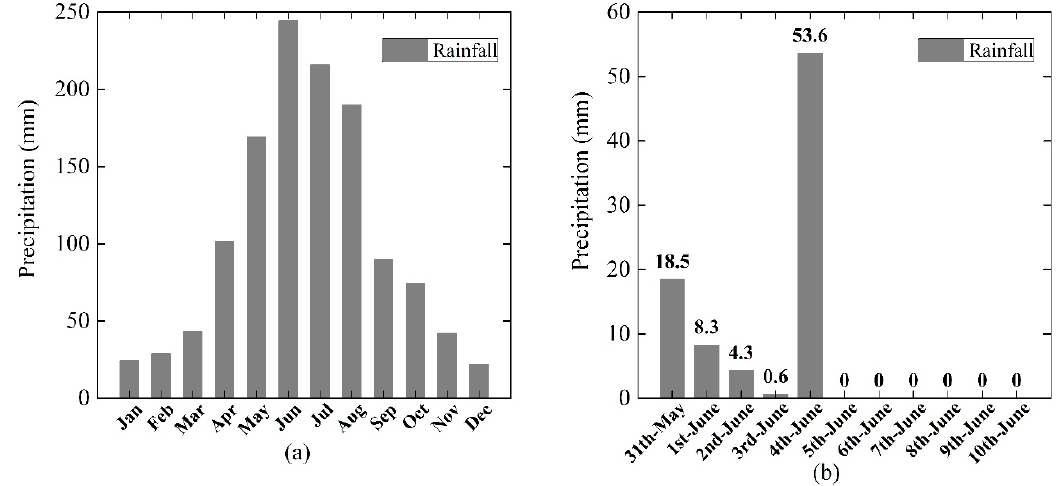
Figure 7. ( a ) Average monthly rainfall in Libo County. ( b ) Rainfall in Libo prior to the incident.